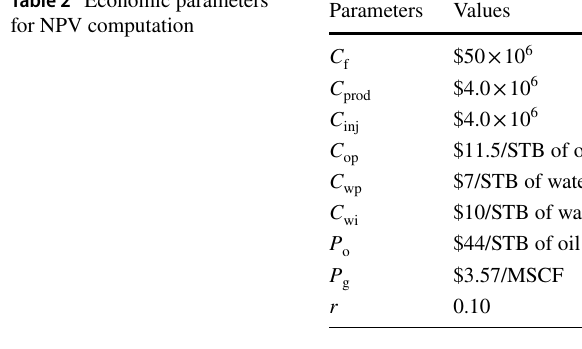
Table 2 Economic parameters for NPV